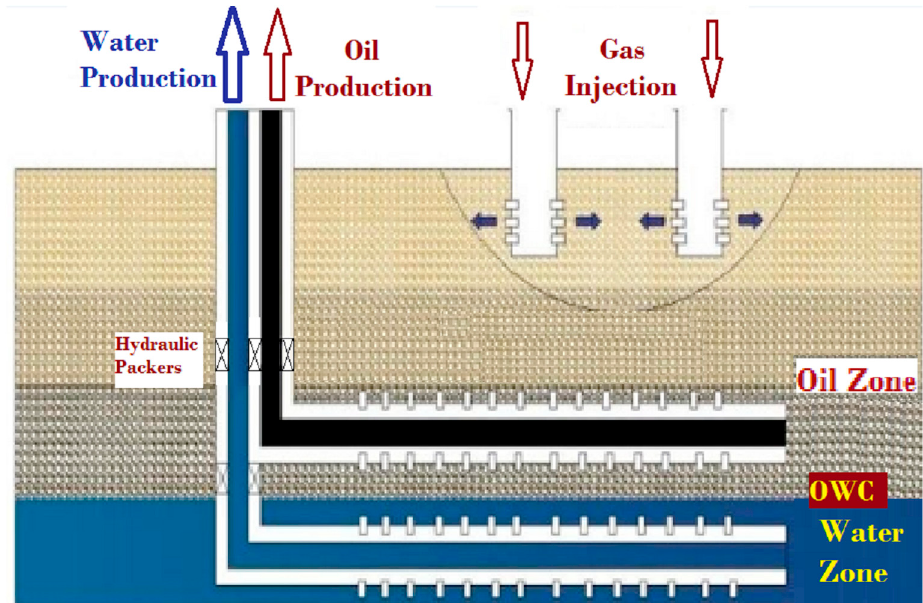
Figure 2. GDWS-AGD gas injector, oil-, and water-producer well configurations. To further reduce premature gas breakthrough and high-water-cut tendencies of GDWS-AGD, it is possible to use triple-completed (TC) wells, incorporating water/oil- production and gas-production completions in each well drilled. This TC-GDWS-AGD approach eliminates the need for drilling separate, vertical gas-injection wells. More specifically, the gas injection is implemented through the wellbore annulus, and oil and water production is accomplished through 2 2 3 / 8 -inch strings of tubing drawing production from perforations located above and below the OWC, respectively. In order to achieve maximum performance of the TC-GDWS-AGD process, it is essential to determine the optimal well placement into the reservoir to attain maximum oil production along with minimum gas injection and minimum water cut. The well placement optimization is a challenging procedure as it is impacted by the fluid properties, reservoir heterogeneity, and the developing history of the reservoir. Thus, the optimal well placement or location has a significant impact on the economic profit of oil field development and thus on the net present value (NPV). The objective function of well placement optimization is a highly nonlinear constraint, and due to reservoir heterogeneity, the decision variables are multi- modal. These optimization problems are typically computationally expensive as they entail full reservoir heterogeneity. Thus, finding optimal well locations with less time and fewer function evaluations is crucial